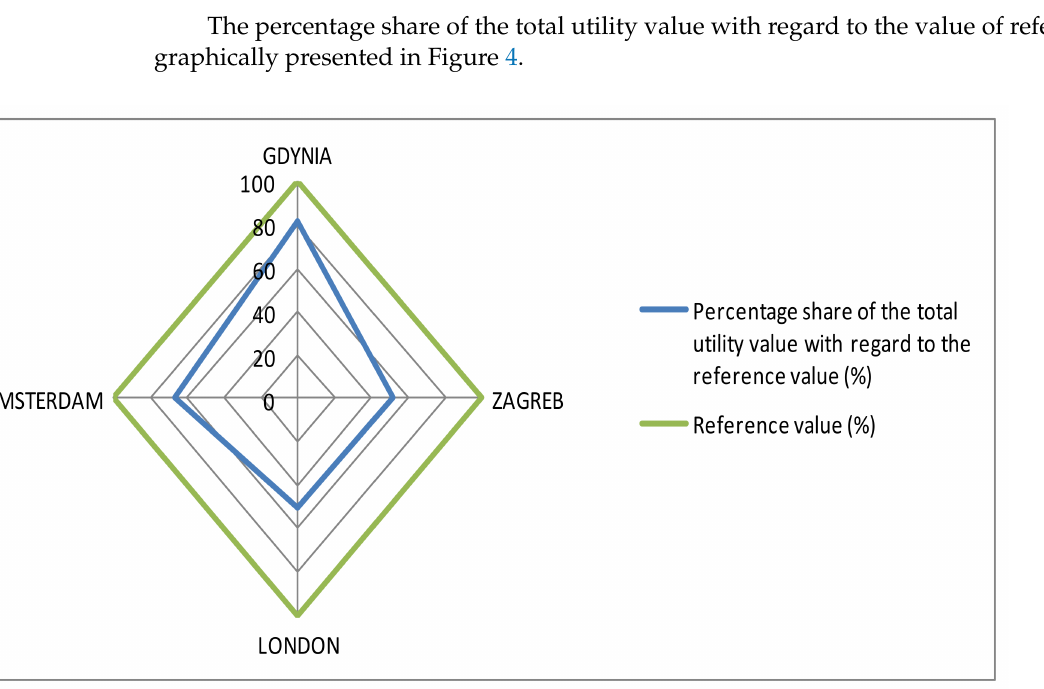
Figure 4. Percentage share of the total utility value with regard to the reference